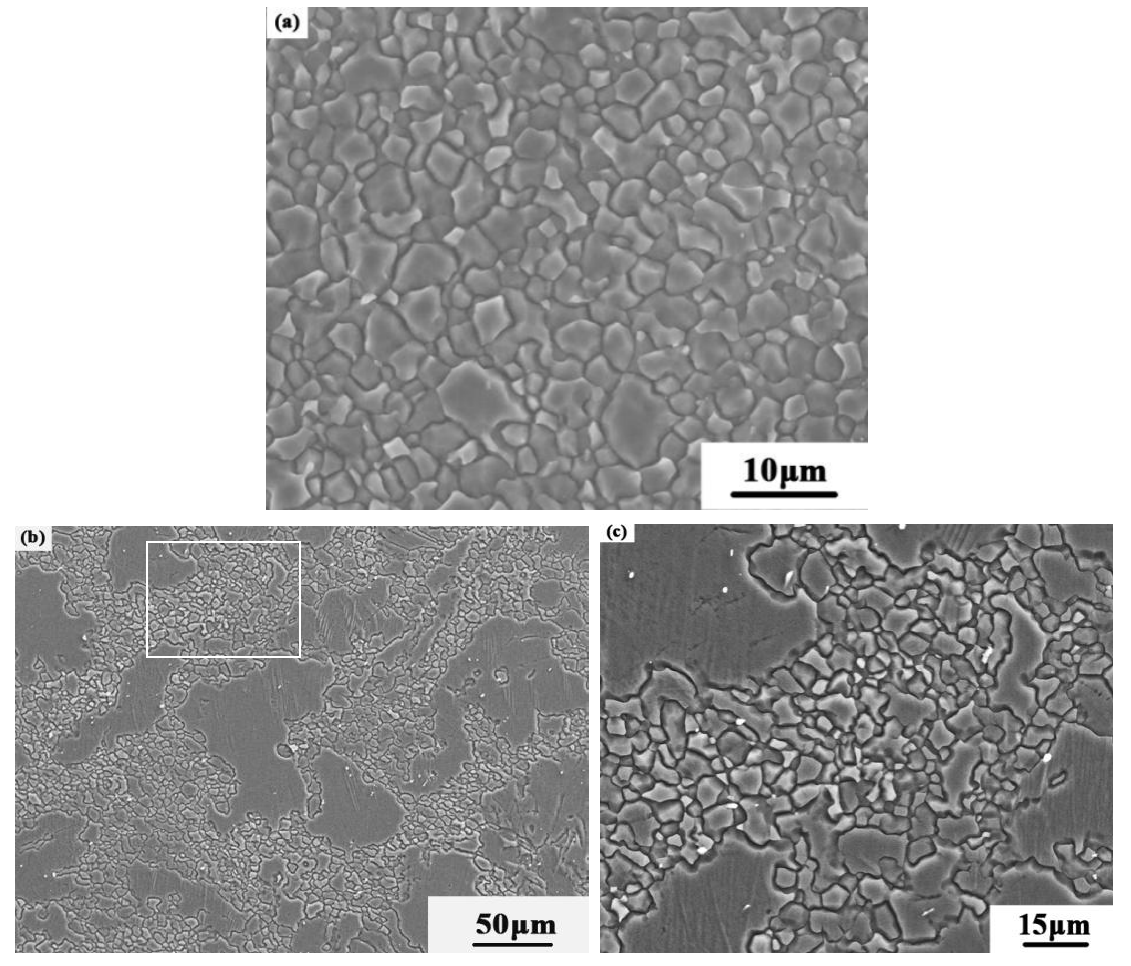
Figure 4. Representative grained structures of the NFSP AZ31 magnesium alloy: ( a ) SZ; ( b ) TMAZ; ( c ) High magnified image of the marked position in Figure